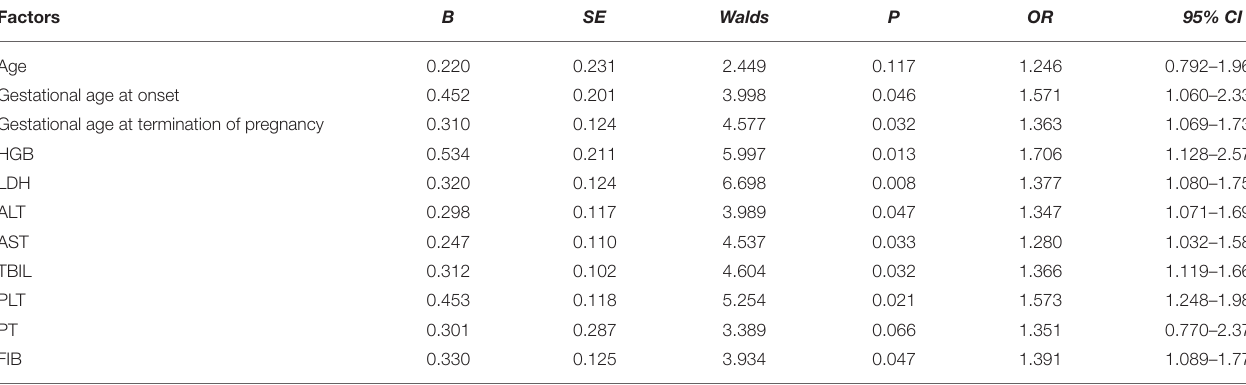
TABLE 5 | Results of a multifactorial analysis of SPE complicated by HELLP syndrome. Factors B SE Walds P OR 95% CI Age